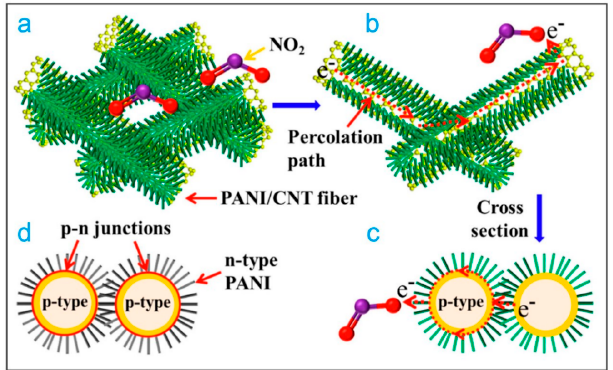
Figure 4. Possible sensing mechanism: ( a ) sketch diagram of conductive network of hierarchical p- PANI/CNT fibers, ( b ) percolation path through conjugate interfaces of PANI and MWCNTs, ( c ) cross-section of PANI/CNT fibers, and ( d ) p-n heterojunction structure of hierarchical n-PANI/CNT fibers [82]. Another research group functionalized CNTs using a carboxylic group to improve the detection of NO 2 gas. The sensing properties were obtained at different temperatures and NO 2 concentrations, which obtained the highest sensitivity of 26.88% at a concentra- tion of 100 ppm tested at RT [83]. Jeon et al. fabricated a NO gas sensor based on CNTs functionalized with an amine group, where the response was 50% at RT [84]. Sensing properties based on sulfuric acid-functionalized CNTs have been reported by Ionete et al. The sensors exhibited good response at RT with high sensitivity when exposed to NO and NO 2 gas at a concentration of 0.04–0.8 ppm [85]. For NO sensing, the sensor showed a response and a recovery time of 255 and 50 s, respectively; whereas, for NO 2 , it exhibited a response and a recovery time of 540 and 420 s, respectively. Finally, carbon nanotubes functionalized with manganese porphyrin have been used for the fabrication of NO 2 sen- sors. The sensors were operated at different temperatures with a high sensitivity at tem- perature of 100 °C [86].